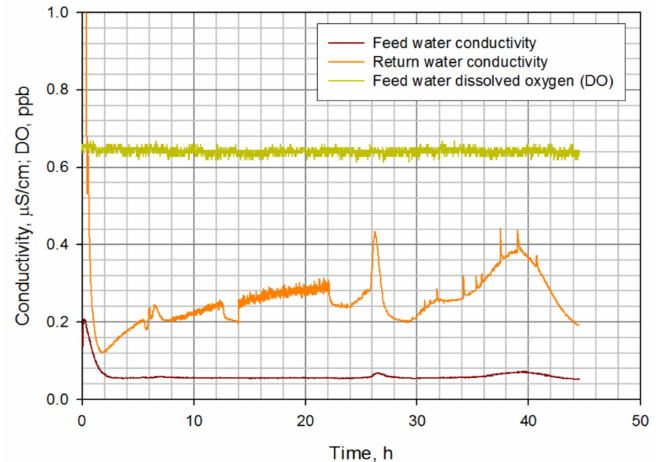
Figure 8. Conductivities and dissolved oxygen during the first operational test of the recircula- tion